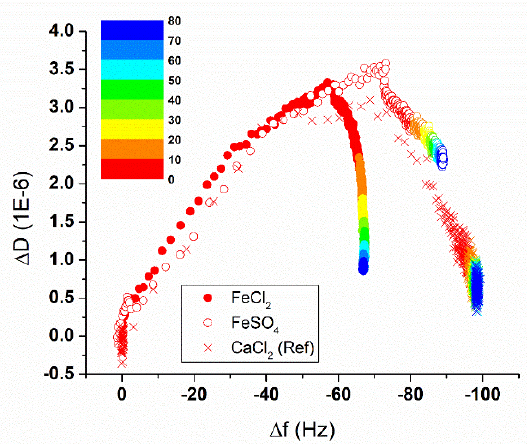
Figure A2. Water contact angle measurements on SbpA films formed from Fe²+ ( a ) or Fe³+ ( b ). Note the wettability change of the film as cause by the structural differences between both samples.